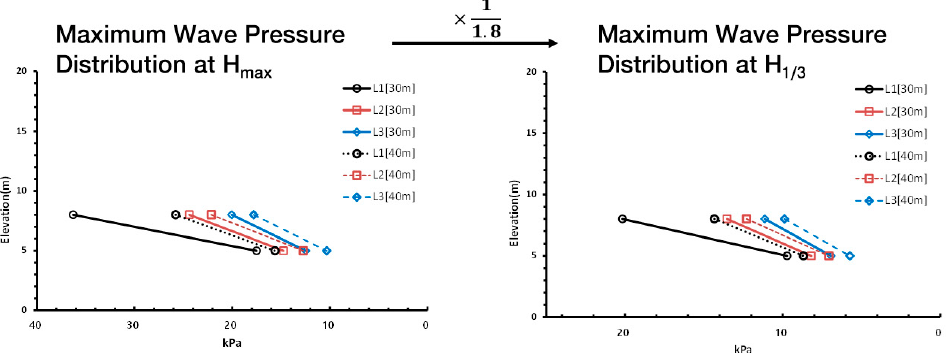
Figure 11. Comparison of the maximum wave pressure at Hmax and H1/3 according to water depth in the two-dimensional cross-sectional hydraulic model experiment.